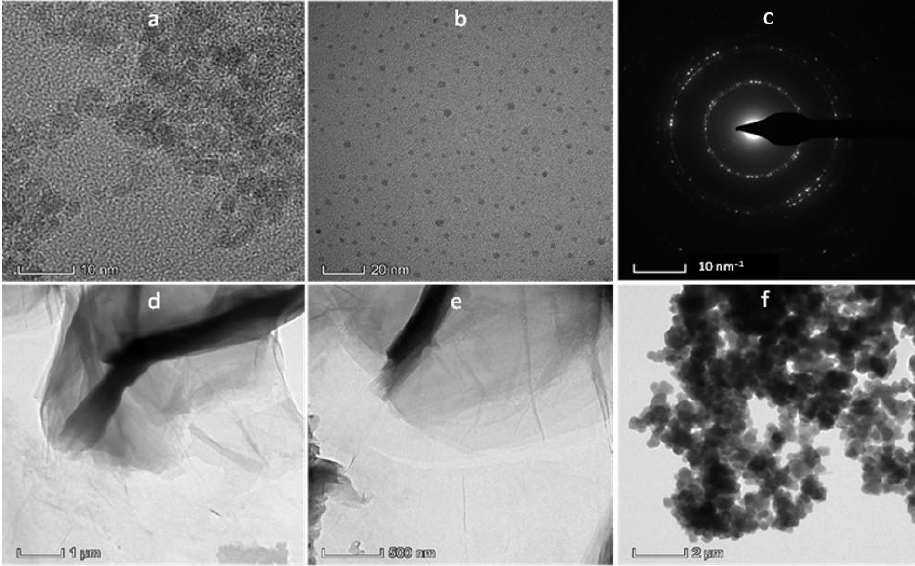
Figure 3. TEM analysis of SnO 2 QDs ( a , b ) SnO 2 QDs; ( c ) SAED pattern of SnO 2 QDs; ( d , e ) TEM image of GO; ( f ) SGP2 composite.